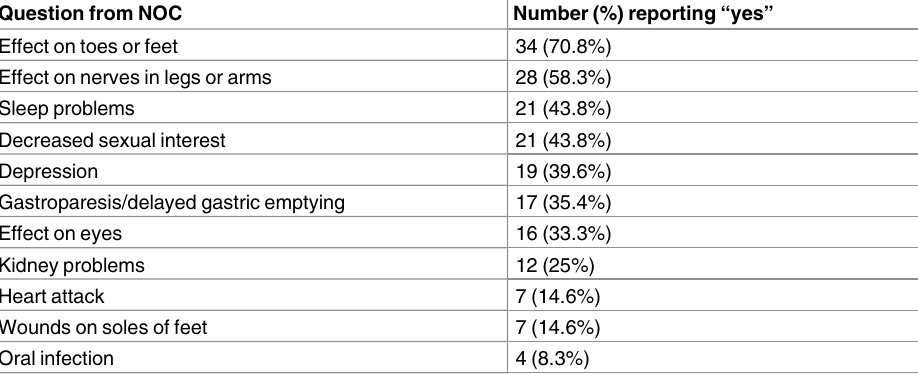
Table 3. Frequency distribution of complications from NOC. Question from